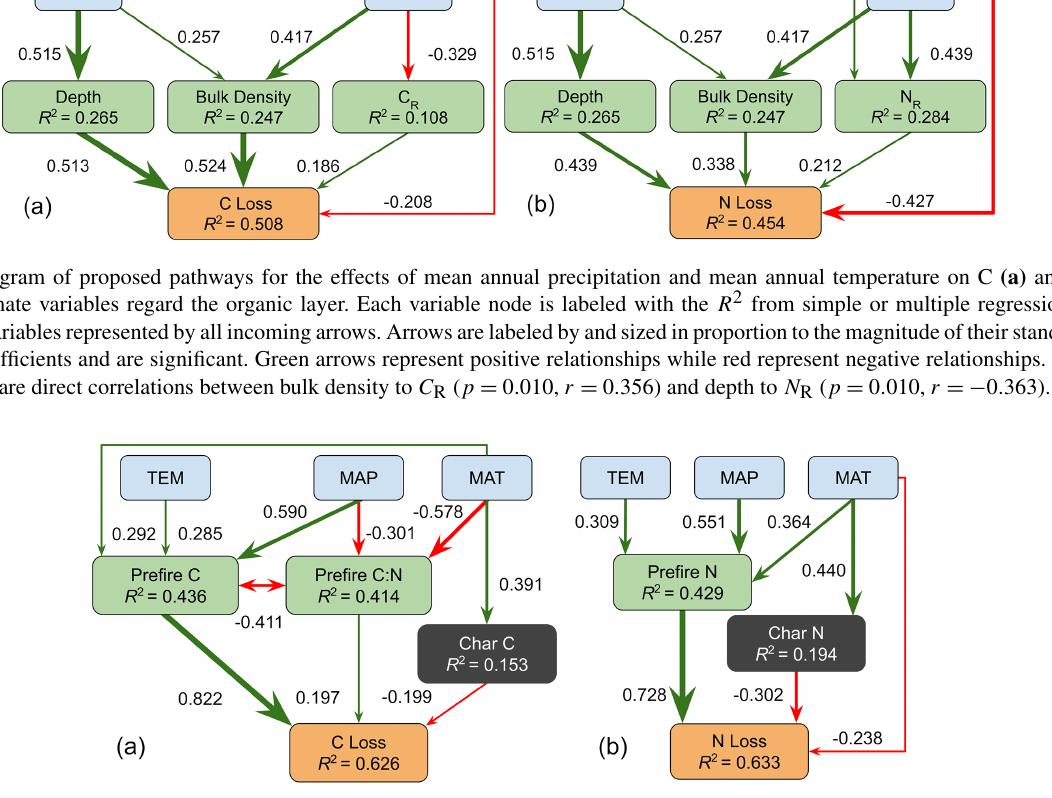
Figure 6. Path diagrams for C (a) and N (b) loss including char and C:N variables. Prefire C, N, and C:N as well as losses of C and N are regarding the organic layer. Each variable node is labeled with the R 2 from simple or multiple regression using explanatory variables repre- sented by all incoming arrows. Arrows are labeled by and sized in proportion to the magnitude of their standardized regression coefficients and are significant. Green arrows represent positive relationships while red represent negative